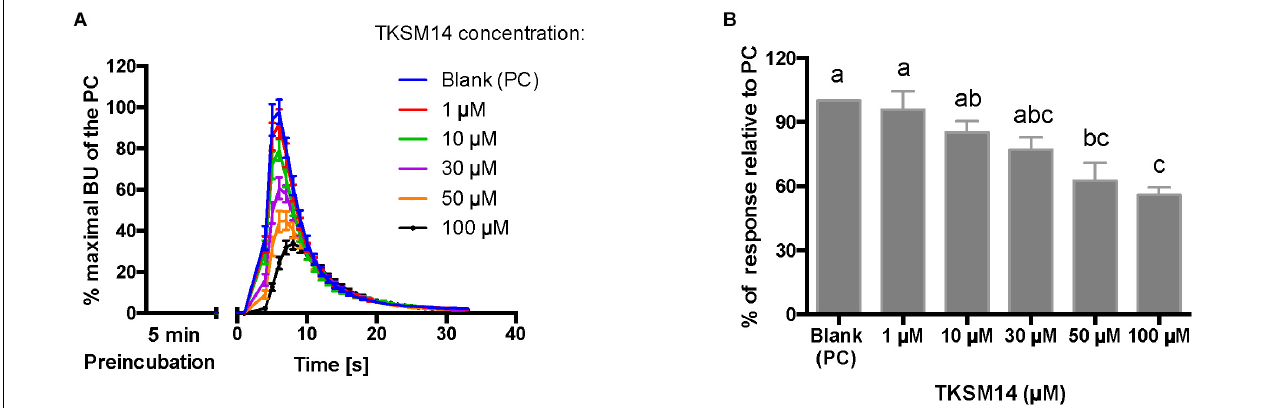
FIGURE 7 | BMLK3 preincubation (5 min) with dosages of TKSM14 before agonist addition, enhances its antagonistic activity in the calcium bioluminescence assay. (A) The kinetic responses of BMLK3 cells to the agonist (1 µ M FFFSWGa) after being incubated with various concentrations of TKSM14 (1–100 µ M) or blank solvent for 5 min. The response was recorded for 30 s at 1 s intervals by the Clariostar TM plate reader (BMG LABTECH). The kinetic response is represented as the percentage of the maximal bioluminescence units (BU) of the positive control (PC = blank buffer + agonist, blue curve) in each assay (Mean ± SEM, n = 9–10 wells from three independent assays). (B) The total cellular response in each well is expressed as the percentage of the average BU (per second) obtained in the 30 s relative to the average response units to the PC in 30 s. Three independent assays were performed. Responses from each assay were calculated as the average of individual responses from 3-4 pseudo-replicate wells ( Y axis: mean ± SEM). Statistical differences in inhibitory activities between different treatment were analyzed by one-way ANOVA ( n = 3) followed by Tukey’s multiple comparison test ( p ≤ 0.05) with GraphPad 6.0 (GraphPad Software, La Jolla, CA, United States). Bars with different letter superscripts indicate significant